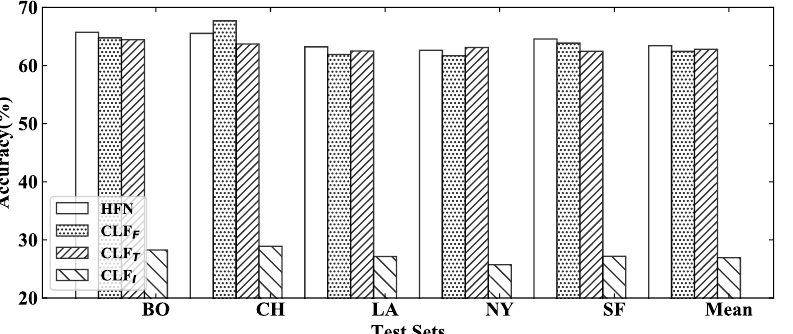
Figure 5. Individual classifiers are expected to output decisions close to true labels which is significant for subsequent decision fusion.